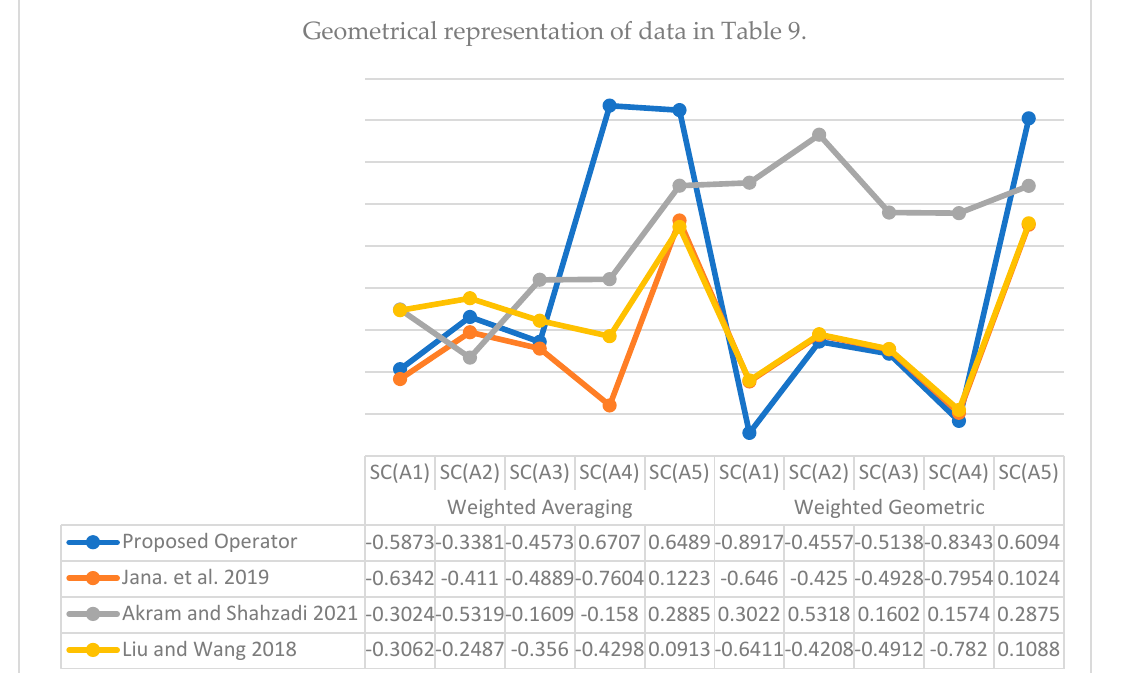
Figure 6. The comparative analysis is represented geometrically in the above graph, where lines show the score values. The results given in row 3 are from Jana et al. [18], the results given in row 5 are from Liu and Wang [35] while the results given in row 4 are from Akram and Shahzadi [38]. The results of Table 9 are described in Figure 6 for further clarity.